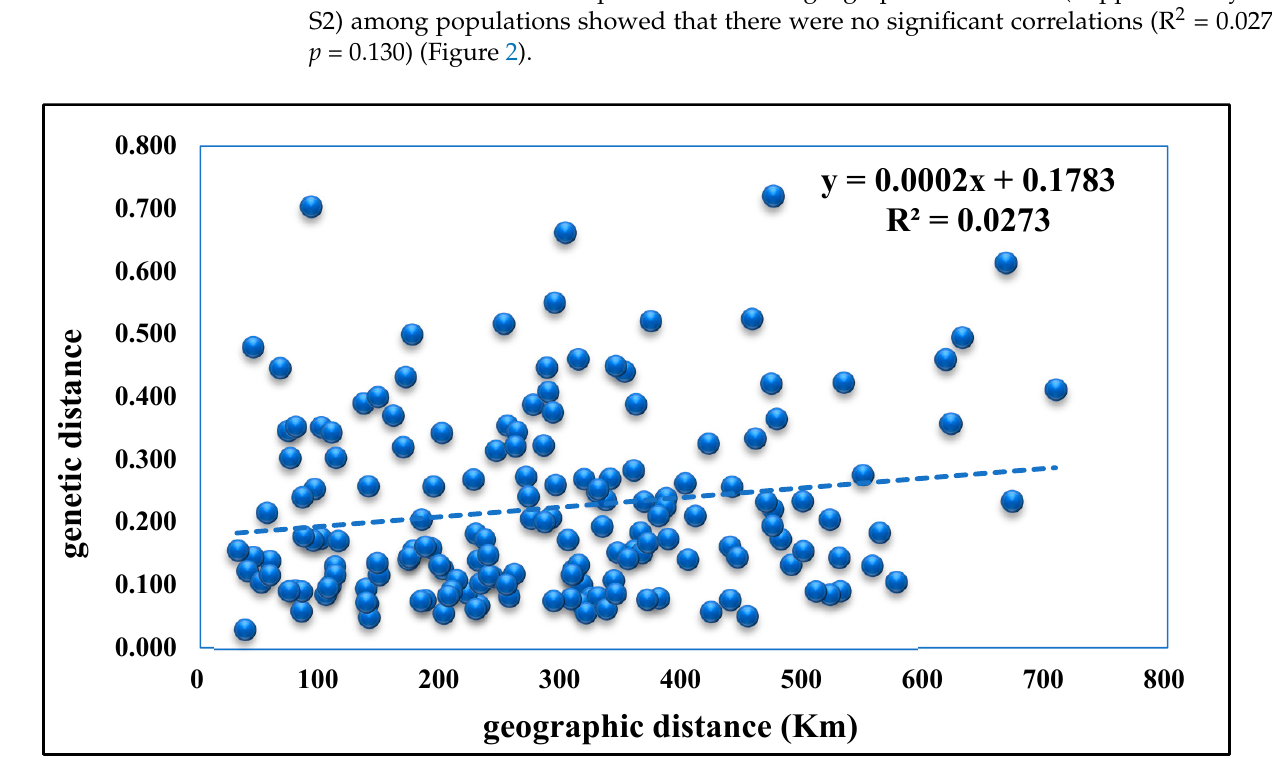
Table 4. Analysis of molecular variance (AMOVA) for 19 populations of ancient P. orientalis .